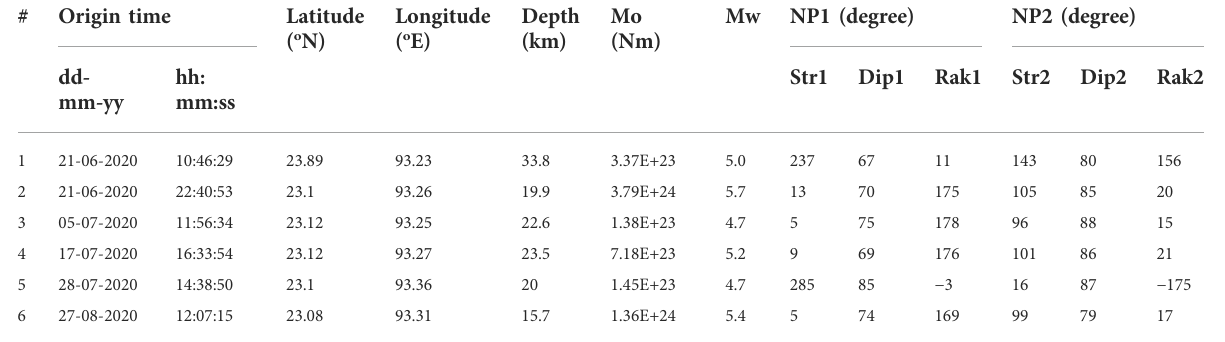
TABLE 3 Fault plane solution of selected events (Source: